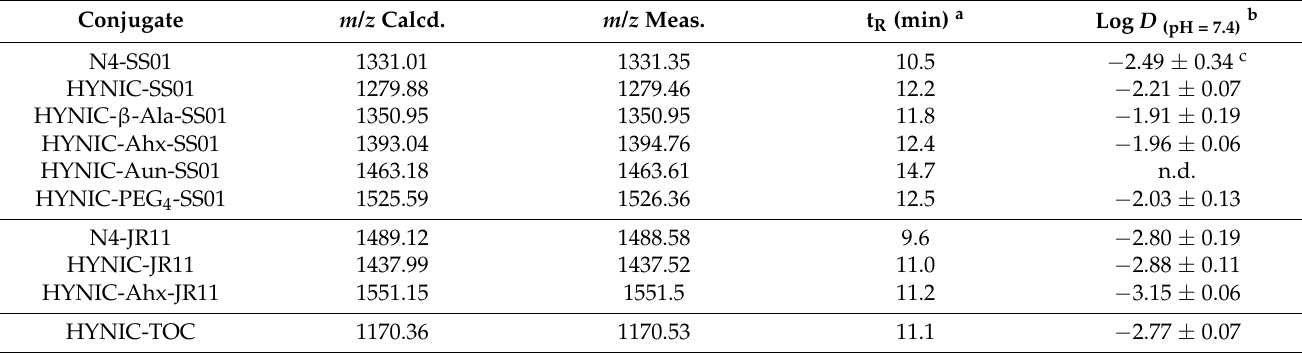
Table 1. Analytical data of studied conjugates and log D (pH = 7.4) of corresponding 99m Tc-labeled conjugates. Conjugate m / z Calcd.